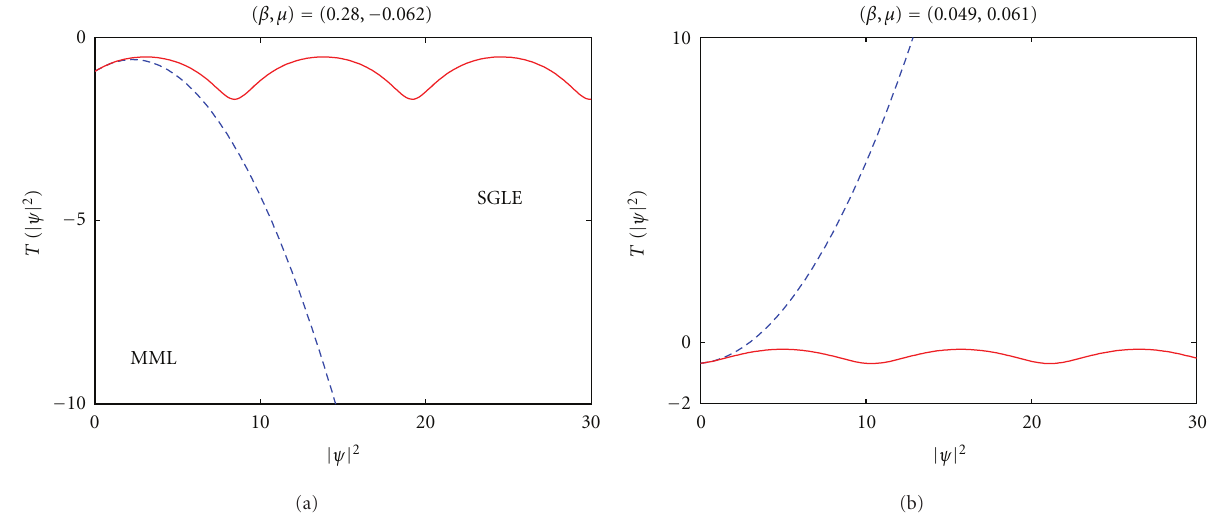
Figure 11: The transmission curve for the CQGLE (blue dashed line) and SGLE (red solid line) for α 2 = 0 . 554 π (a) and α 2 = 0 . 4 π (b). The rest of the parameters are α 1 = 0 . 1 π , α 3 = 0 . 23 π , α p = 0 . 43 π , Γ = 0 . 1, e 0 = 1, and K = 0 . 1 (from [29], 2011,